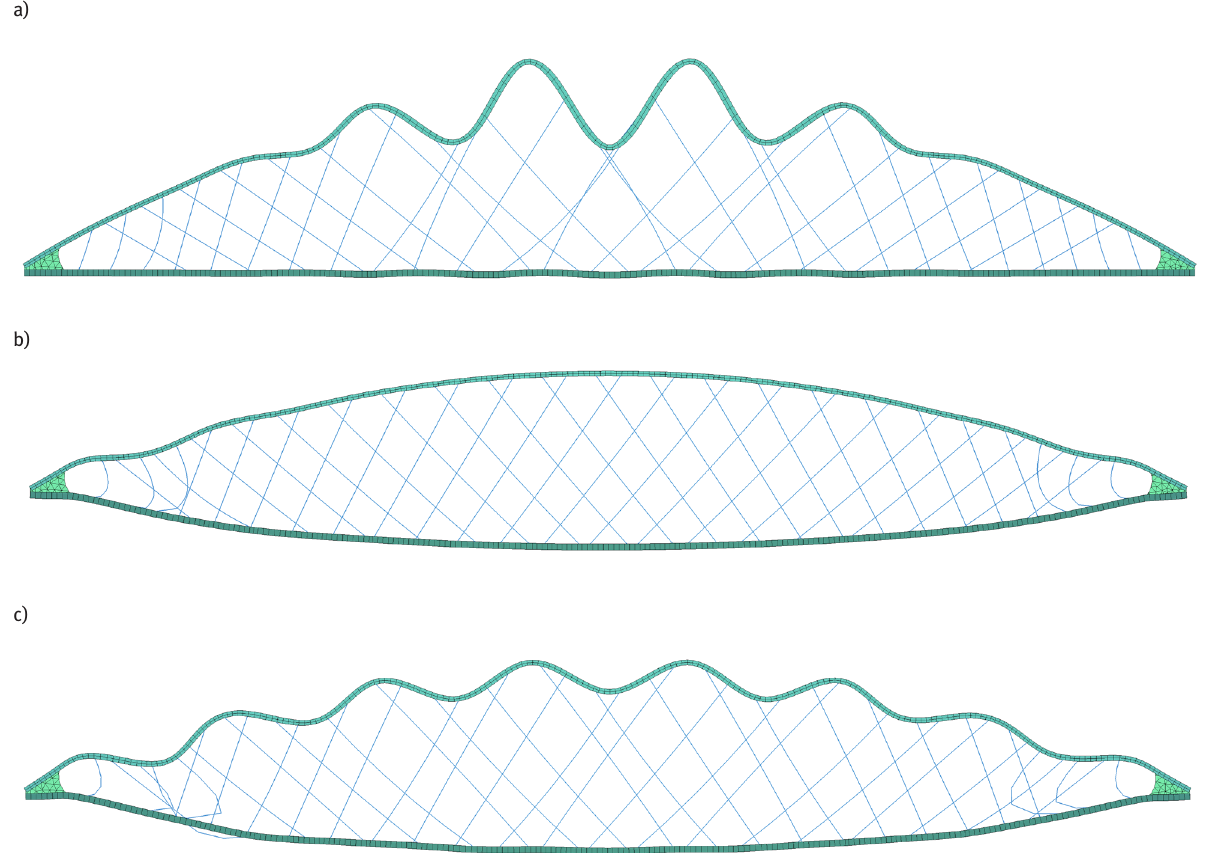
Figure 17: Deformations form: LBA (a), last ULTI step (b), and PUSH after 50 steps (c).